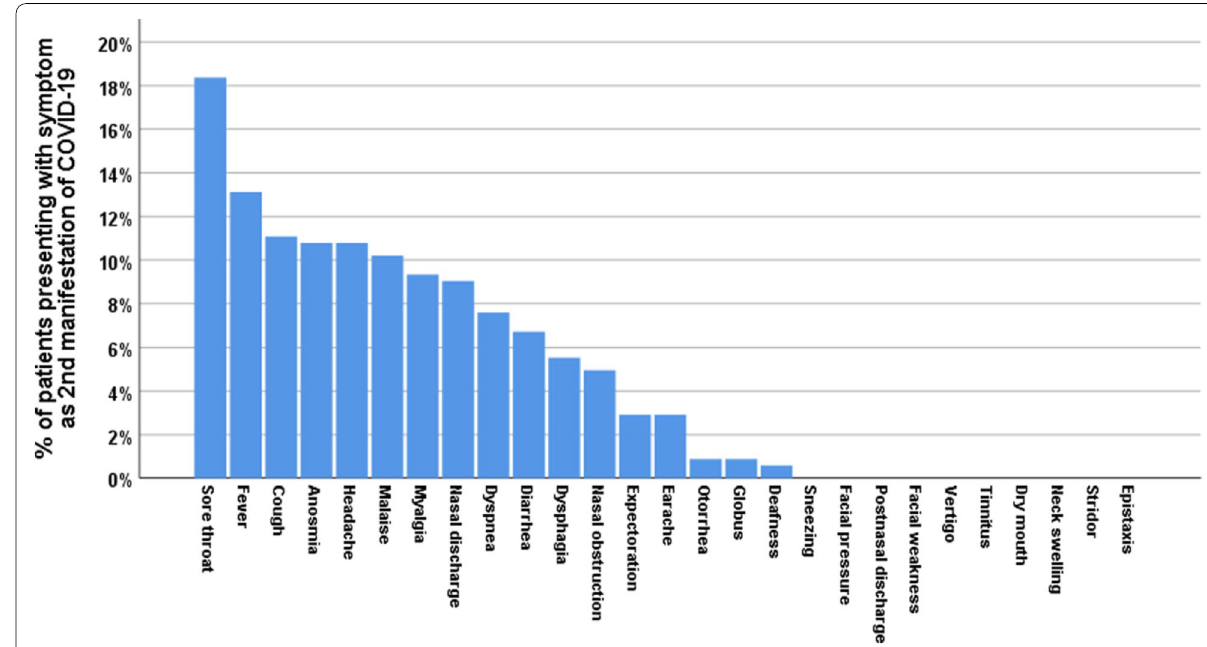
Fig. 3 Percentage of patients presenting with various symptoms (ORL, non-ORL) as second manifestation of